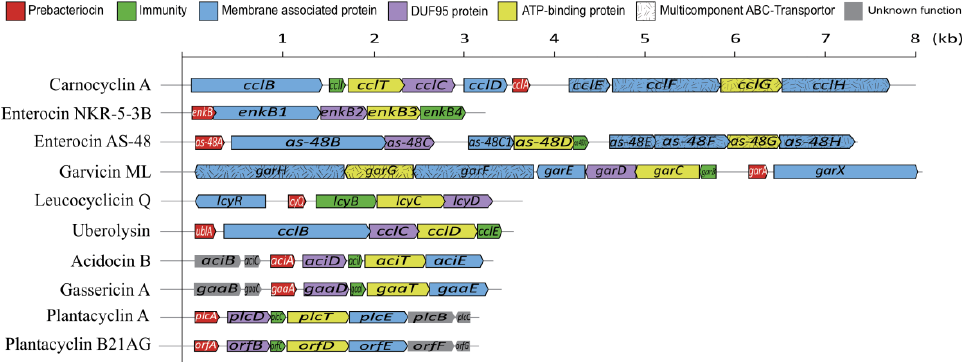
Figure 5. Organization of biosynthetic gene clusters of class IIc bacteriocins of LAB.